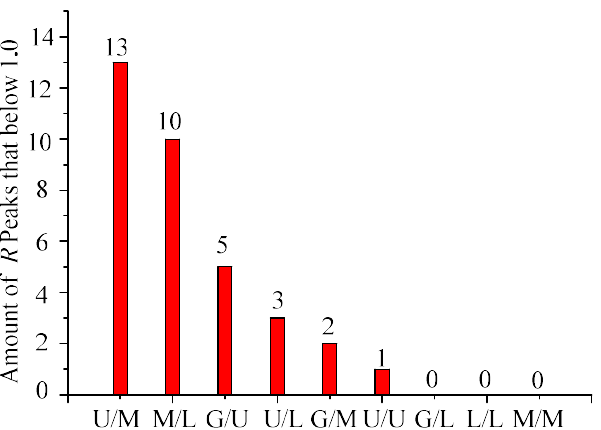
Figure 13. Detailed information of conductors / ground wires. Notes: U is upper conductor, M is middle conductor, L is lower conductor, and G is ground wire.